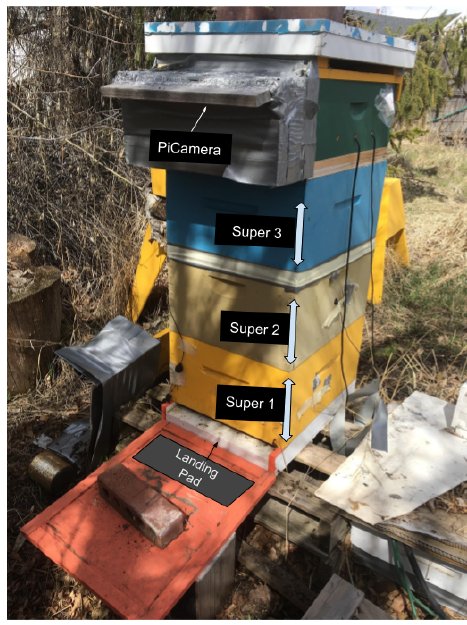
Figure 1. A BeePi monitor box on top of a Langstroth beehive that consists of 3 supers; the camera is protected against the elements with a specially constructed wooden box. More hardware details are available at [42,43].